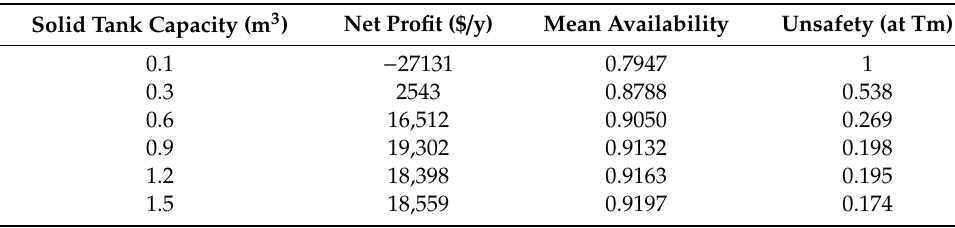
Table 8. Results of the dependability